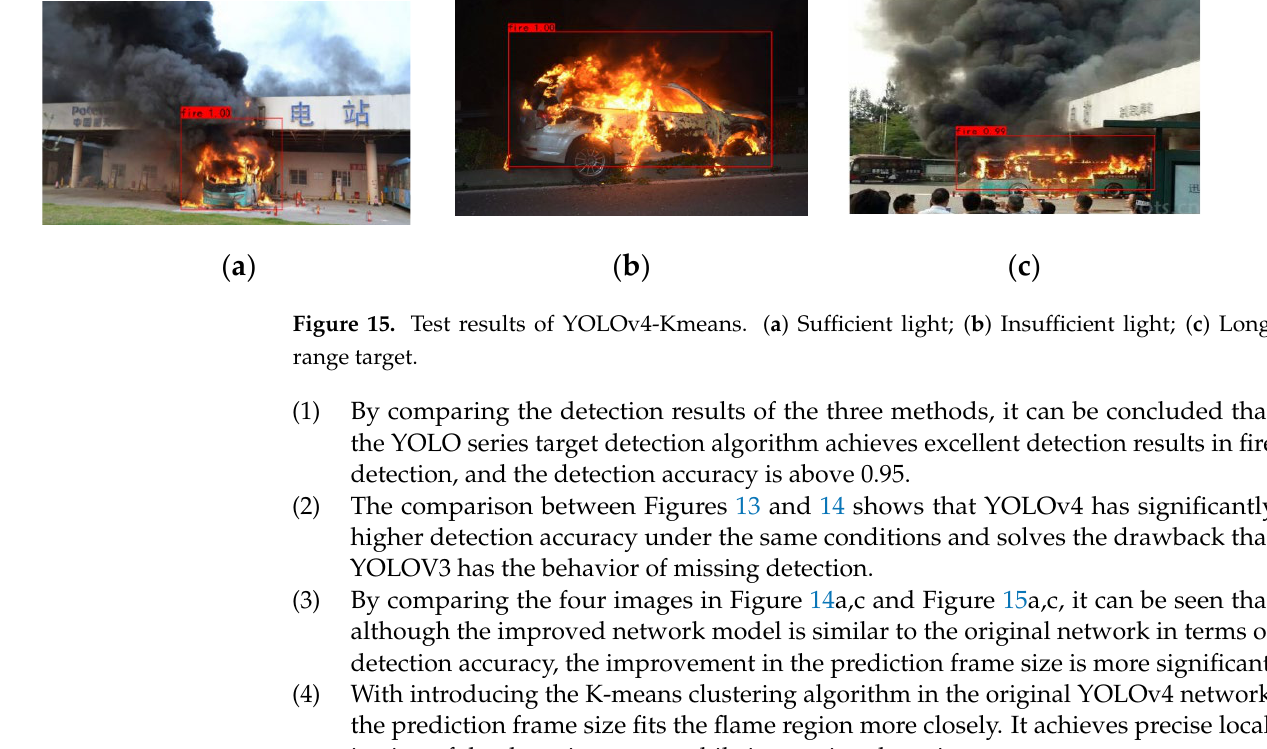
Figure 14. Test results of YOLOv4. ( a ) Sufficient light; ( b ) Insufficient light; ( c ) Long-range target.